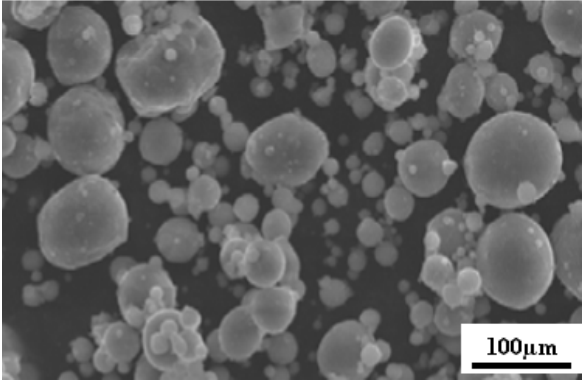
Figure 1: (SEM) Scanning electron micrograph of Al-12Si powder particles